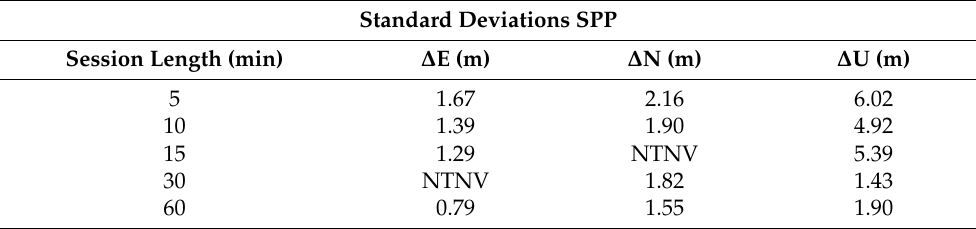
Table 6. Standard deviations for SPP sub-datasets: ∆ E, ∆ N, ∆